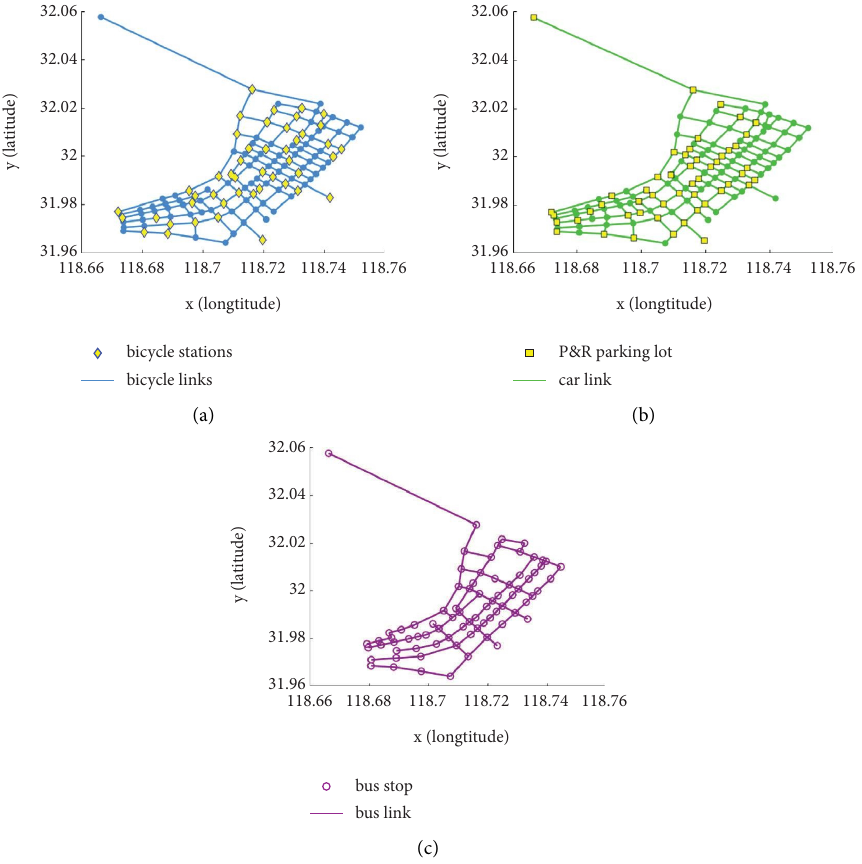
Figure 13: Subnetworks of the best solution. (a) Bicycle subnetwork. (b) Car subnetwork. (c) Bus